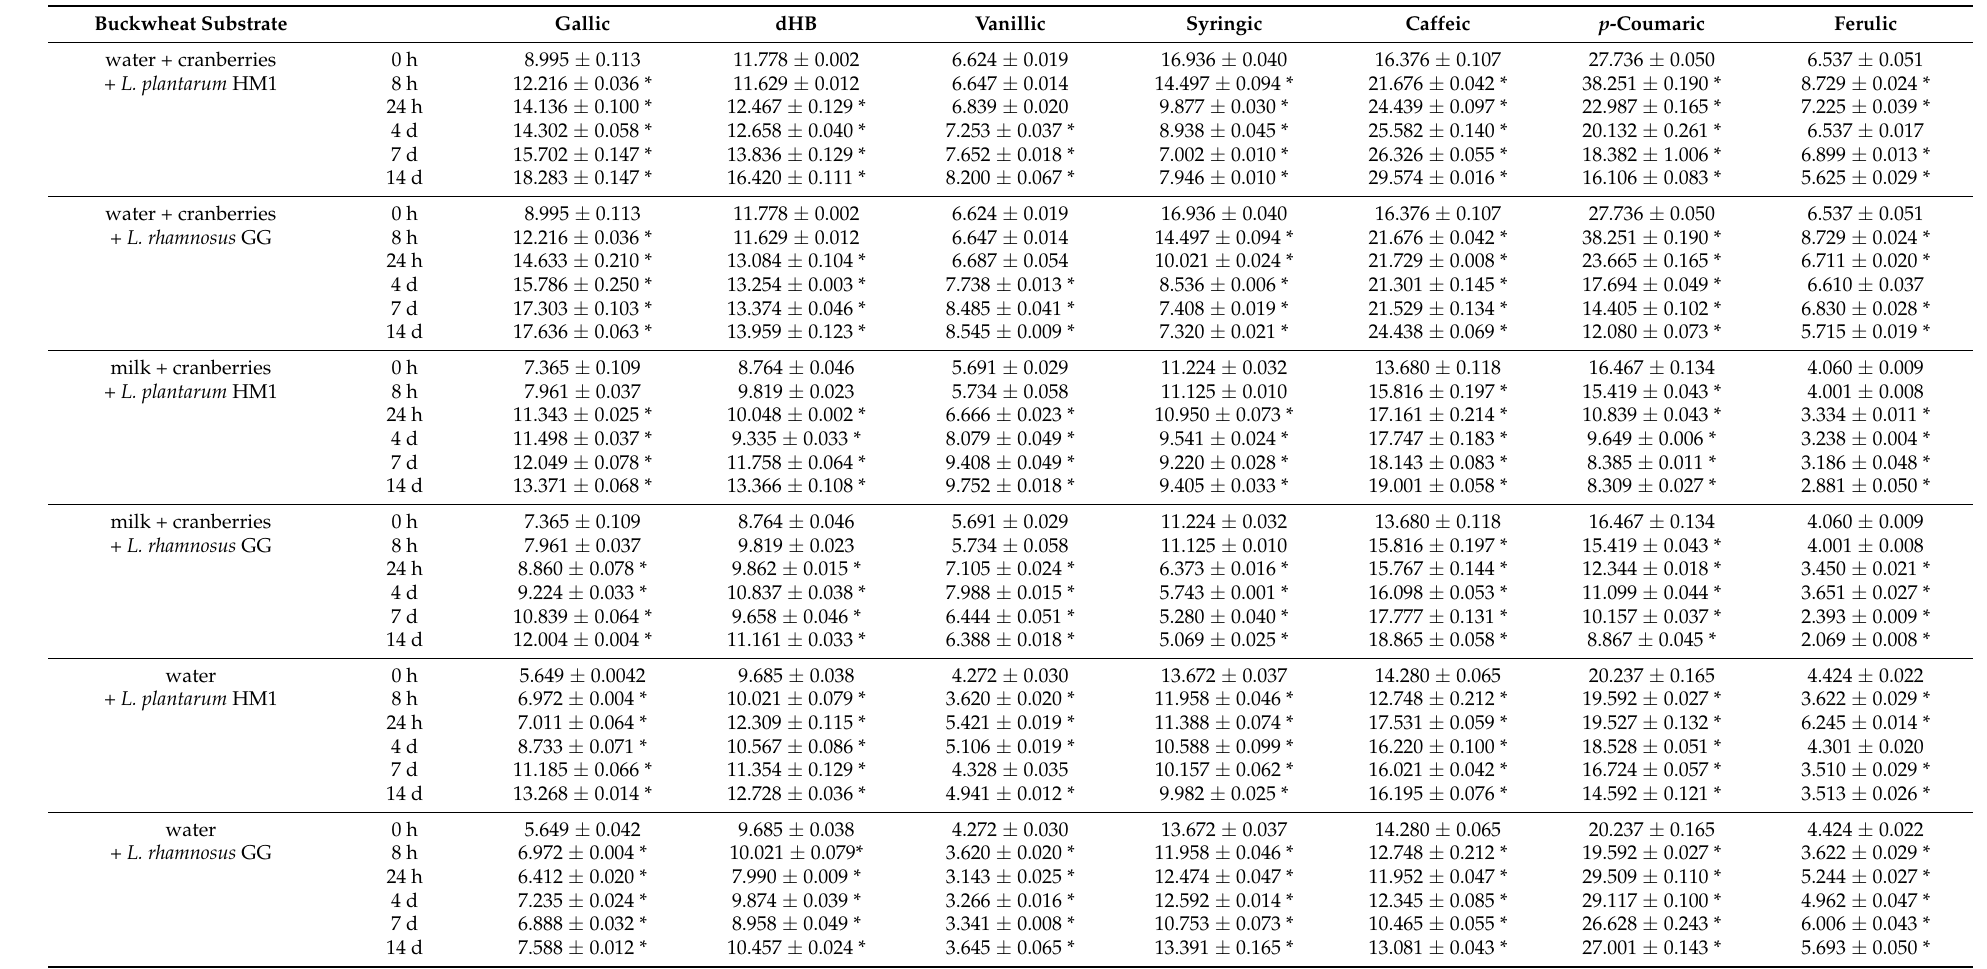
Table 4. Phenolic acids profile in buckwheat mashes obtained by HPLC analysis ( µ